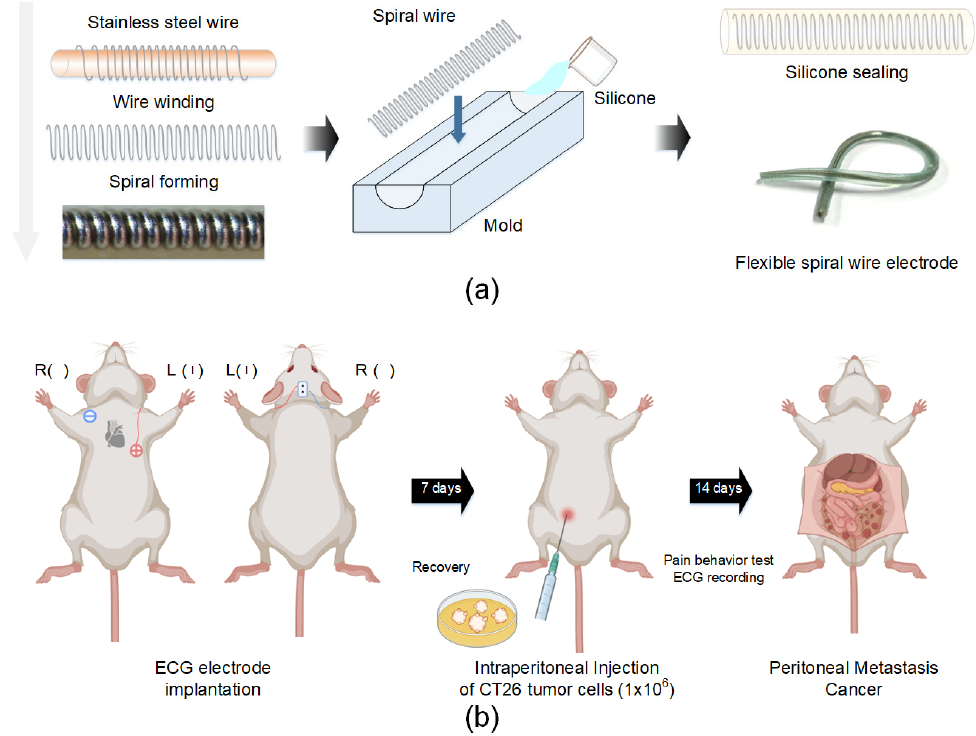
Figure 1. An overview of the experimental procedures and illustration. ( a ) Fabrication process of the flexible wire electrode. ( b ) Implantation of the ECG electrode in mice and the peritoneal metastasis cancer model.